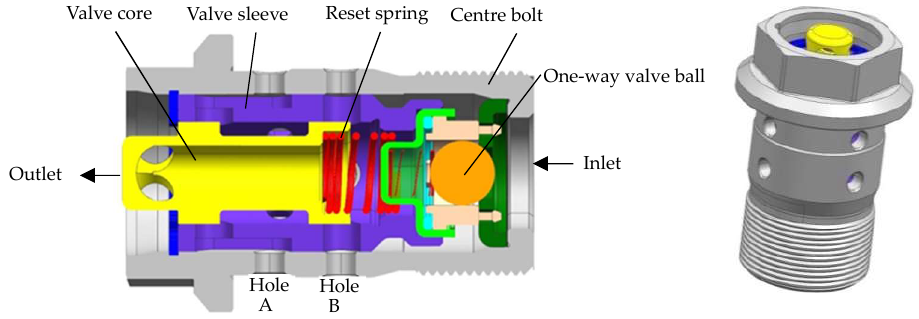
Figure 1. Structure of the slide valve body of OCV.